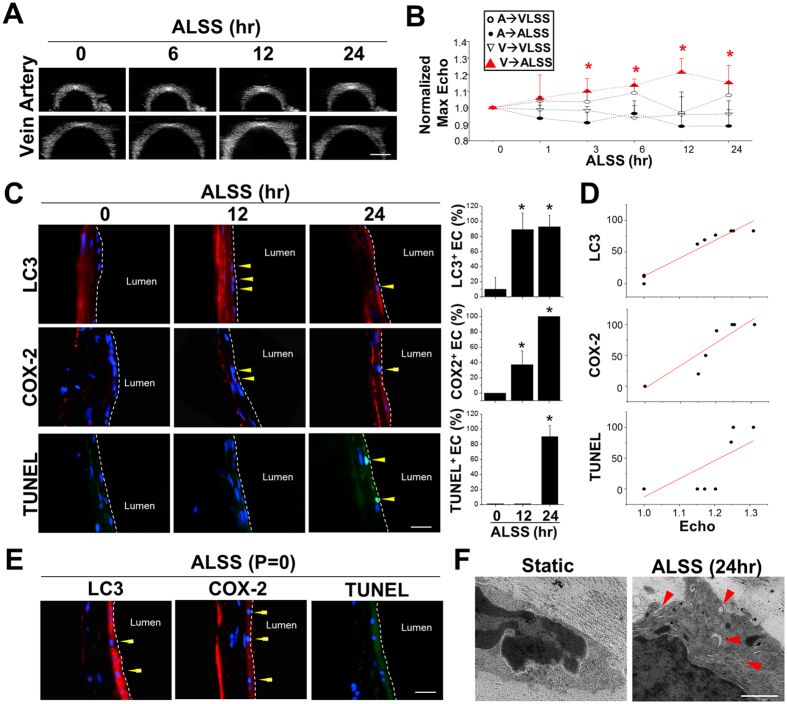
Detection of ALSS-induced vein damage in the ex vivo system.The HFU images of the isolated artery and vein perfused with arterial laminar shear stress (ALSS, 12 dyn/cm2) at 0, 1, 3, 6, 12, and 24 hrs (A). Quantification of the normalized maximum echogenicity (normalize to the same vessel at 0 hr) showed that ALSS increased the echogenicity when perfusing the vein for 3 to 24 hrs (max at 12 hrs), but not in the artery or when subjecting either artery or vein to VLSS (n = 5) (B). The immunofluorescence staining of cross-sectioned venous tissues demonstrated that ALSS induces venous EC autophagy formation at 12 and 24 hrs (red color for LC3 expression), COX-2 expression (mild level of red color at 12 hrs, and high at 24 hrs), and EC apoptosis at 24 hrs after ALSS application (green color for TUNEL positive cells) (n = 5) (C). Strong positive correlations of echogenicity were observed with LC3 and COX-2 expressions (n = 5) (D). The ALSS-induced autophagy in venous ECs was confirmed morphologically by the accumulation and formation of double-membrane autophagosomes (arrowheads) using transmission electron microscopy (E). Without arterial pressure, the ALSS still induced venous EC damage with accompanied by the positive staining of LC3, COX-2, and TUNEL (F). Scale bar: 20 μm. *Significant difference from the results at 0 h, p < 0.05.